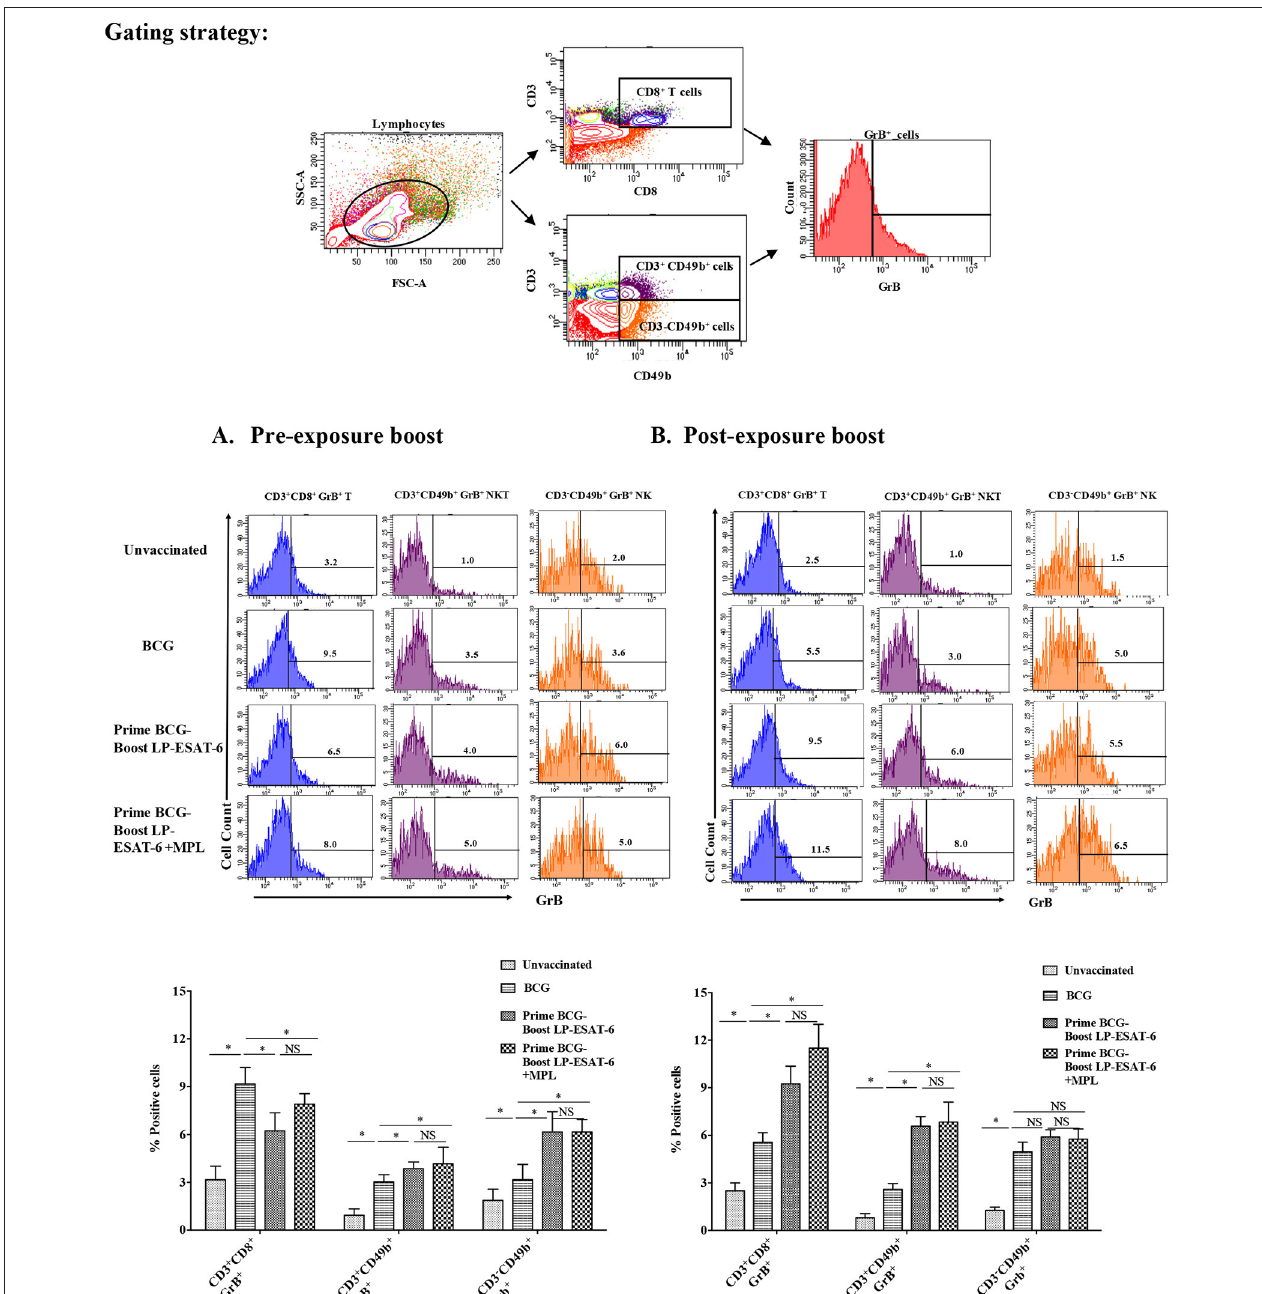
FIGURE 6 | Induction of granzyme B (GrB)-producing effector lymphocytes including NK and NKT and CD8 + T cells in BCG-primed mice boosted with LP-ESAT-6 subunit vaccine in the pre-exposure or post-exposure schedule. Female BALB/c mice ( n = 5/group) were immunized according to the pre-exposure or post-exposure schedule shown in Figure 1 . Four weeks after infection, mice were euthanized and spleens were collected from (A) pre-exposure boost and (B) post-exposure boost groups. Spleen cells obtained from individual mice were cultured for 5h with Brefeldin A (1.5 µ g/ml) 1X; eBioscience), and labeled with antibodies against CD3, CD8 and CD49b for extracellular staining along with intracellular GrB. The cells were gated for CD3 + CD8 + , CD3 − CDCD49b + (NK) and CD3 + CDCD49b + (NKT) cells, which were subsequently analyzed for GrB expression as shown in the gating strategy above the bar graphs in each panel. Data are shown as the percentage of GrB + of CD3 + CD8 + , CD3 − CDCD49b + and CD3 + CDCD49b + cells from each of the experimental groups: unvaccinated, BCG alone, BCG prime/LP-ESAT-6 boost and BCG prime/LP-ESAT-6 + MPL boost in (A) pre-exposure and (B) post-exposure schedules. Histograms of GrB + cells are shown in the top panel and bar graphs representing mean ± standard deviations from five individual mice are shown in the bottom panel in each of the schedules (A,B) . *denotes significant difference ( P < 0.05) between the compared groups and “NS” represents not significant ( P > 0.05). Data are representative of two repeated experiments.